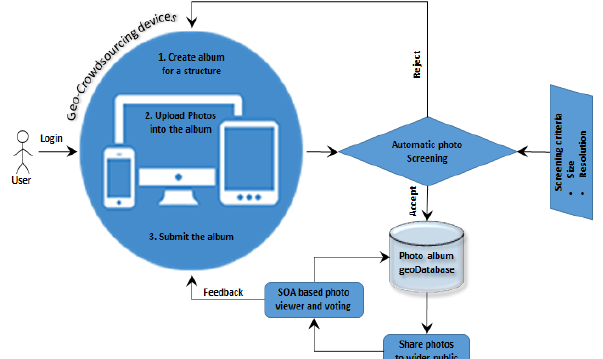
Figure 2. Data flow of the crowdsourcing platform